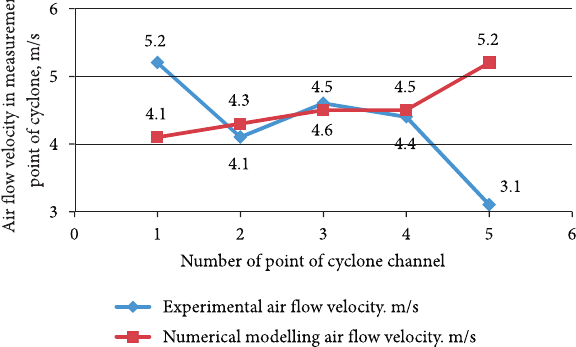
Fig. 5. Experimental studies and numerical simulations to obtain the gas flow shear velocities in the first channel of cyclone